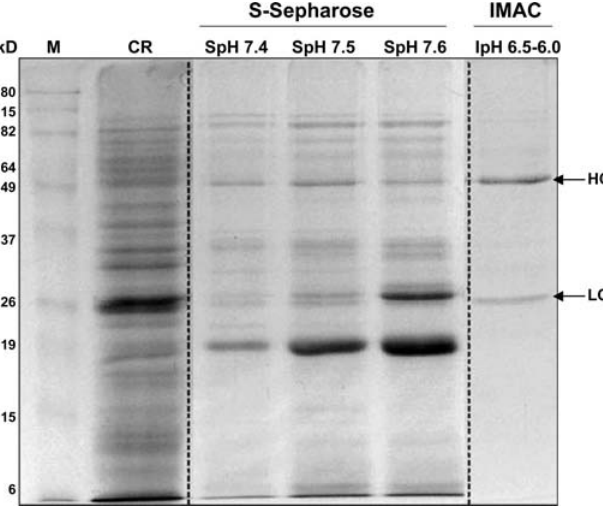
SDS/PAGE of selected fractions from non-protein A purification procedure. Lanes are marked as follows: M, markers; CR, transgenic maize crude extract; SpH 7.4-SpH 7.6, pool of eluted fractions at pH 7.4–7.6 from S-Sepharose FF cation exchanger; and IpH 6.5–6.0, pool of eluted fractions at